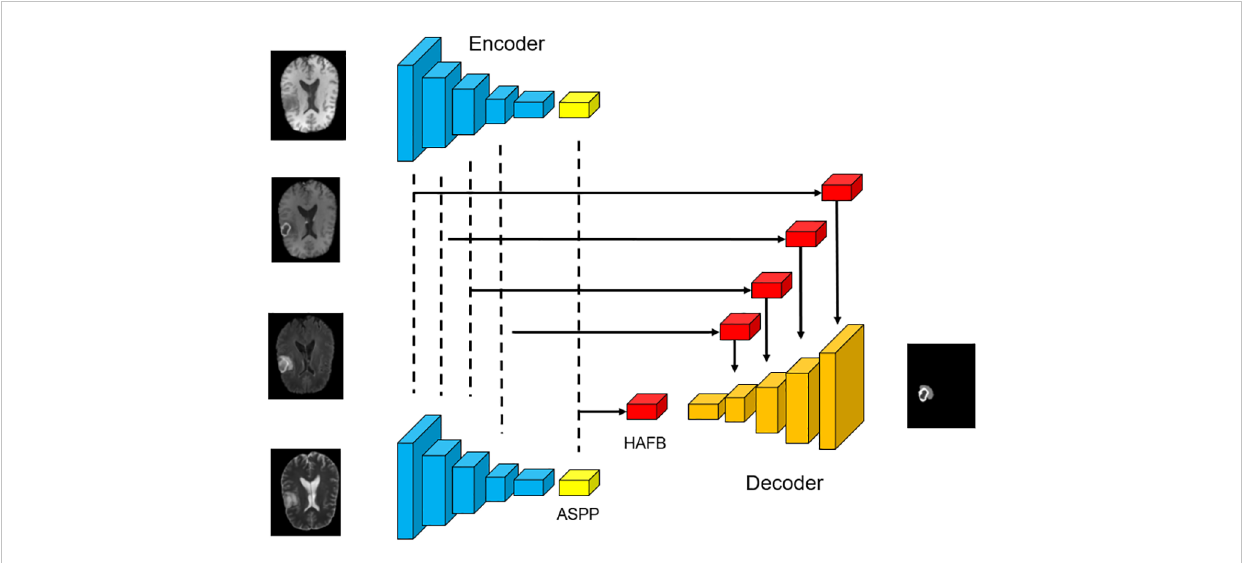
FIGURE 1 The overall structure of the network. The basic framework used in this work is Res-UNet with skip connections and residual convolution, which is suitable for automatic segmentation of brain tumor medical